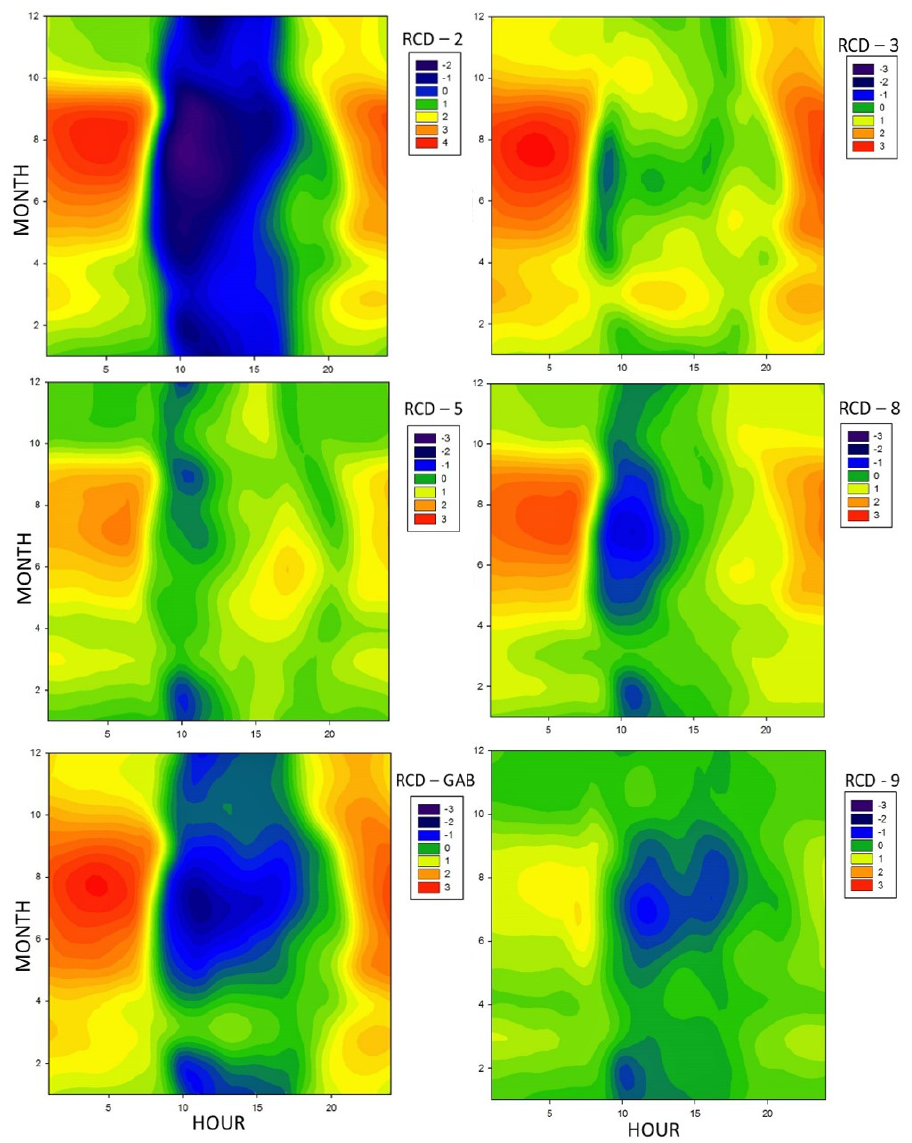
Figure 5. Daily and seasonal variation for the UHI effect for each LCZ ( ∆ T ) in ◦